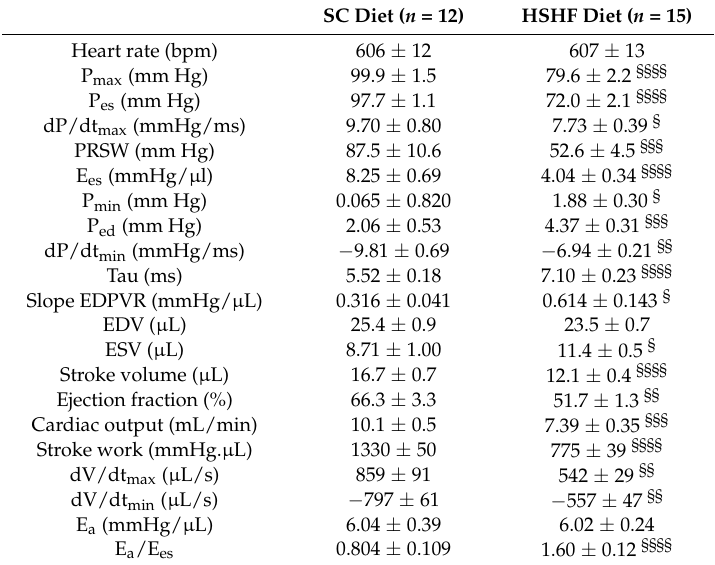
Table 3. Overview of hemodynamic data in C57BL/6N mice fed the SC diet or the HSHF